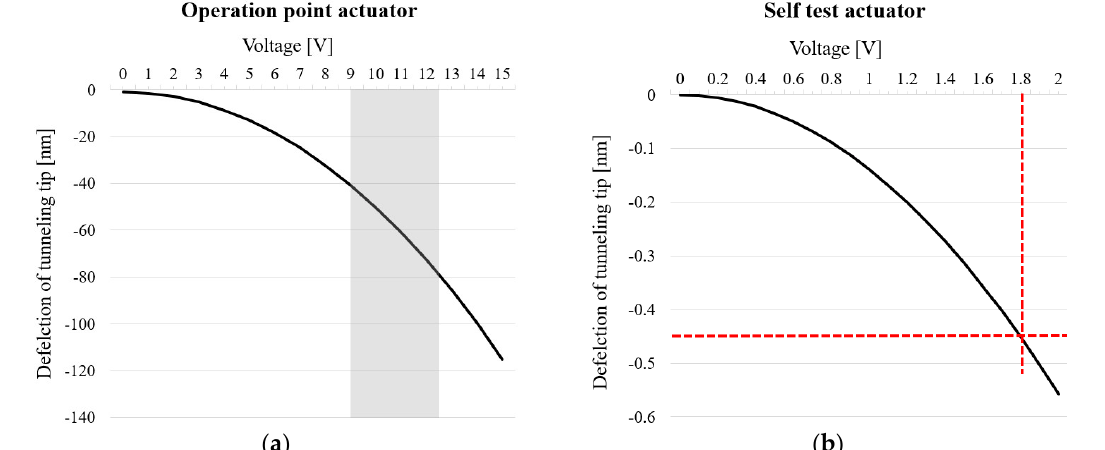
Figure 3. ( a ) Shows the deflection of the actuator reaching the operation point at 1 nm. Depending on the FIB deposition to manufacture the tunneling tip, the voltage varies between 9 and 12.5 V. The grey column shows the operation range. The impact of the self-test can be seen in ( b ). The example of a 0.5 g step is highlighted with dash